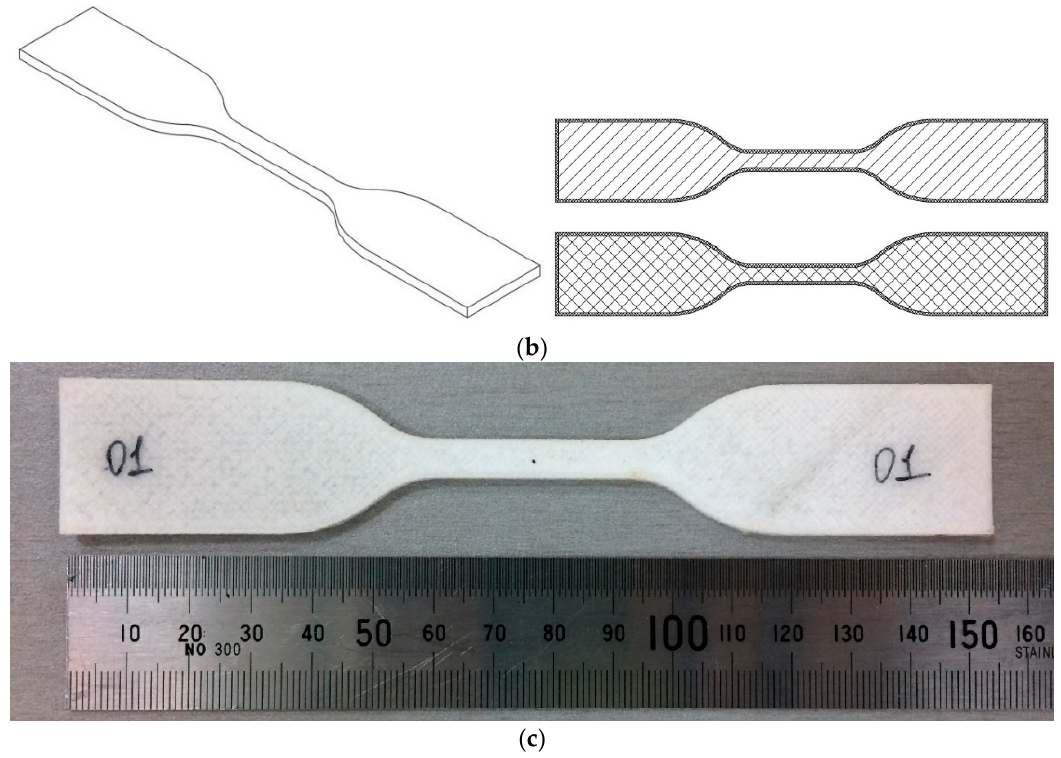
Figure 1. Sample in accordance with GOST ( a ), the layer infill scheme ( b ), real specimen ( c ).